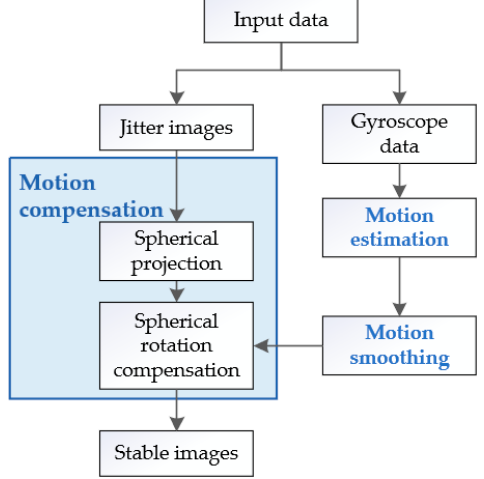
Figure 1. Framework of the proposed algorithm.